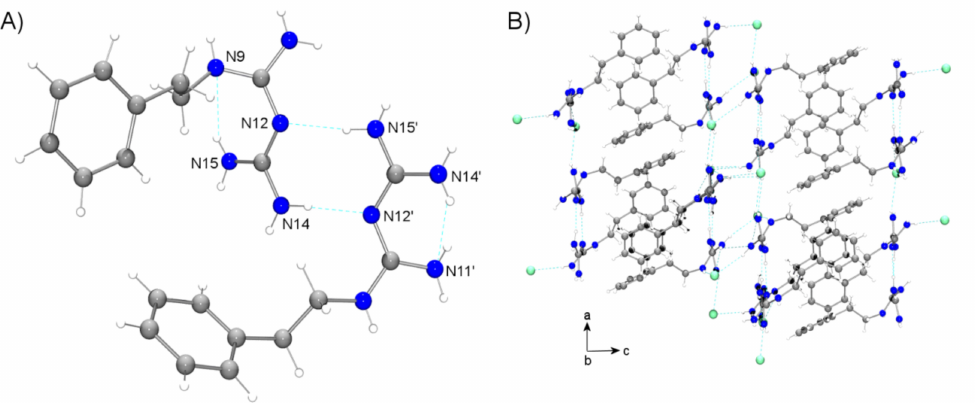
Figure 3. ( A ) H-bonded dimer of phenformin ligands within the crystal of phenformin hydrochloride [37], H-bonded as depicted as dashed cyan lines, and chloride ions have been omitted for clarity. ( B ) Crystal packing of phenformin hydrochloride